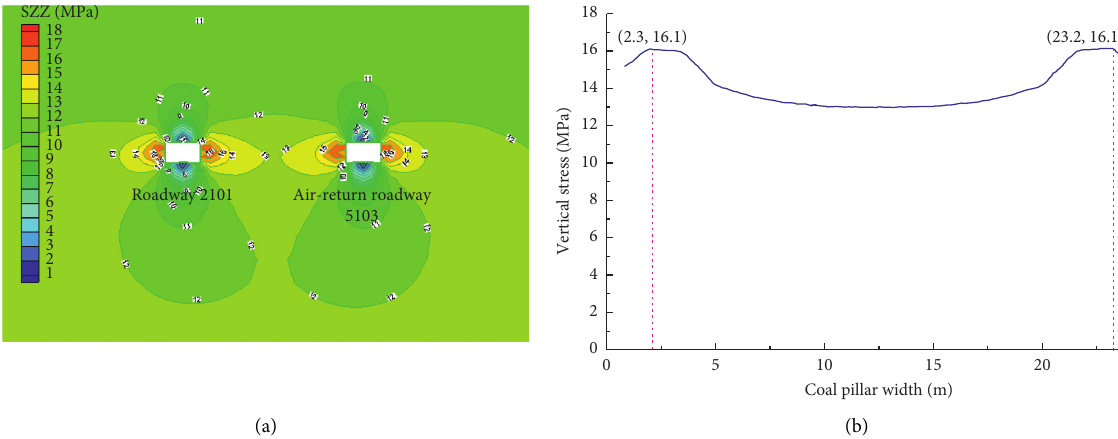
Figure 2: Vertical stress distribution of the surrounding rock and coal pillar during the excavation of air-return roadway 5103. (a) Vertical stress of the surrounding rock. (b) Vertical stress of the coal pillar.